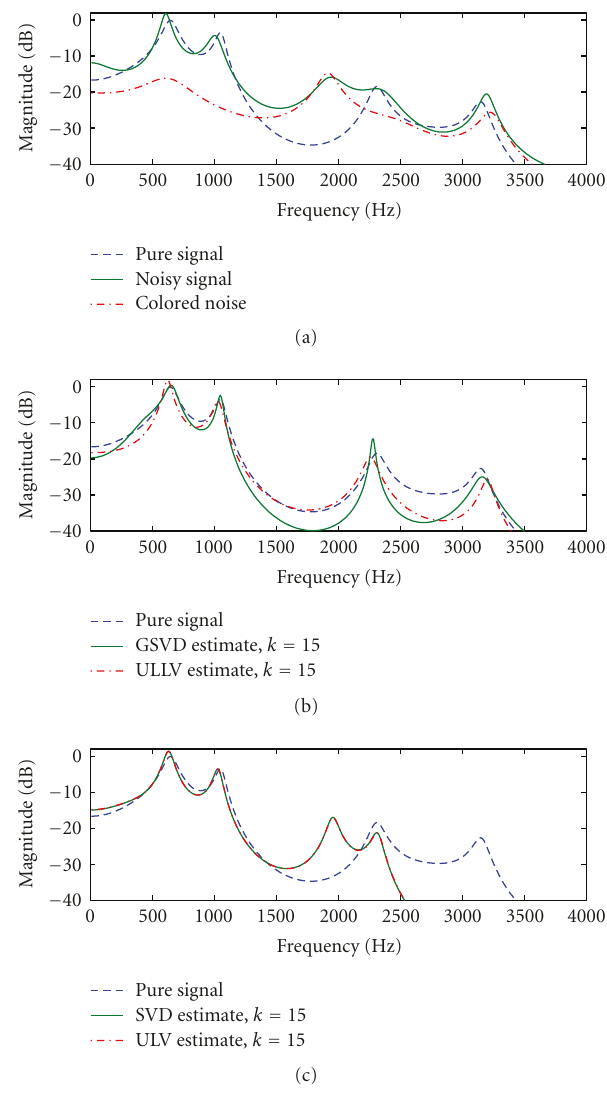
Figure 7: LPC spectra of the signals in the colored-noise exam- ple, using the MV estimates. (a) Clean and noisy signals together with the noise signal; (b) GSVD and ULLV estimates; the SNRs are 12.1 dB and 11.4 dB; (c) SVD and ULV estimates (both SNRs are 11.4 dB). Without knowledge about the noise, the SVD and ULV methods mistake some components of the colored noise for a sig- nal.